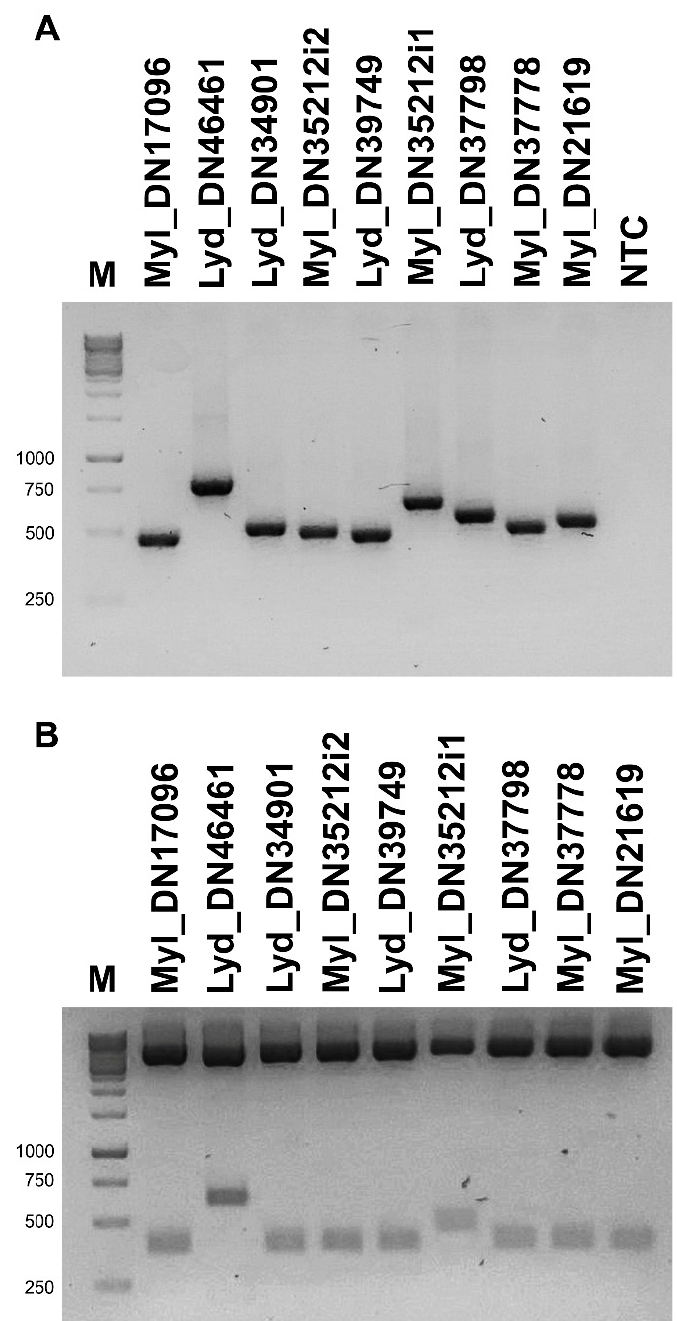
Figure 4. Cloning of nine Kunitz sequences. ( A ) PCR fragments were run on 1.8% agarose gel showing the expected molecular weights. Transcript and protein sequences from sequenced clones. ( B ) pCR2.1 vector containing the 9 Kunitz sequences was digested with Eco RI and run on 1.8% agarose gel, showing the expected molecular weights. M, 1 Kb DNA ladder; NTC, negative